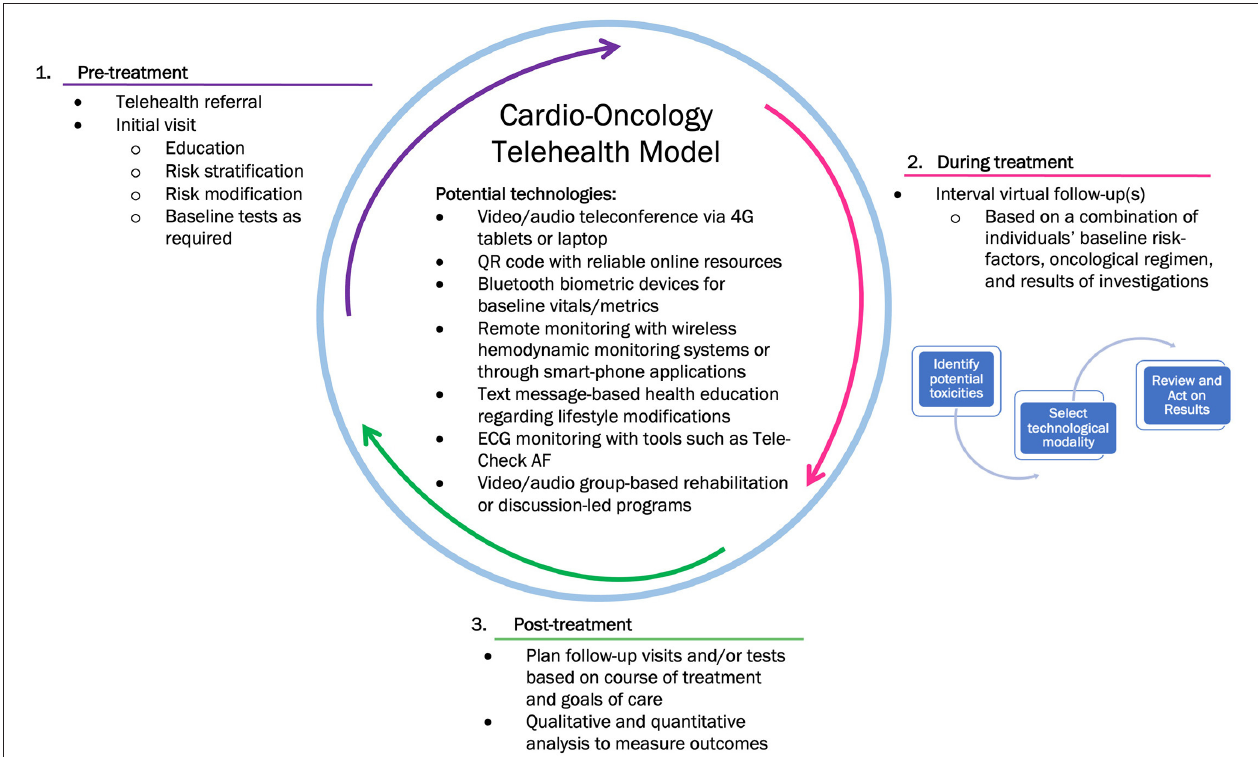
FIGURE 1 | Proposed phases of care in a cardio-oncology telehealth